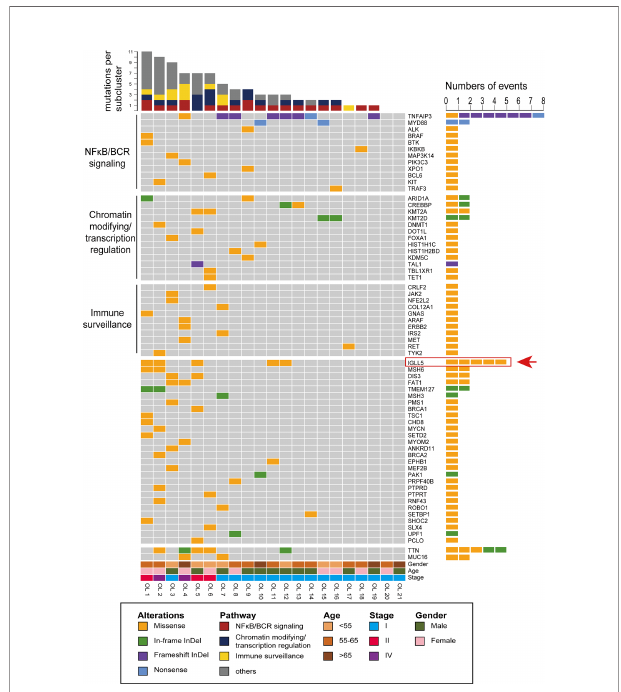
FIGURE 2 | Recurrent targets of genetic alterations identi fi ed in OAML. The heatmap plot of the somatic mutations in the studied entities showing all nonsynonymous mutations detected by whole-exome sequencing (WES). Each column represents an ocular adnexal marginal zone B-cell lymphoma (OAML). Each row represents a gene divided by pathway and ordered from top to bottom in descending order of the tumor ’ s detection frequency. When multiple mutations occur within the same gene, the most harmful mutation is